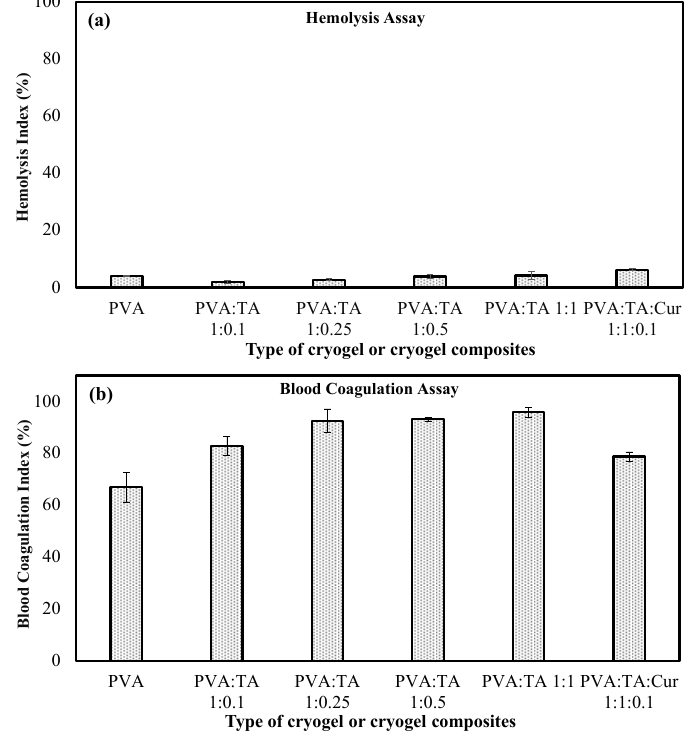
Figure 4. TA and Cur release profiles from PVA:TA:Cur 1:1:0.1 cryogel composites, ( a ) TA release profiles in EtOH and EtOH:Wat by UV-Vis spectroscopy, and ( b ) Cur release profiles in EtOH and EtOH:Wat by fluorescence spectroscopy. Digital camera images of these cryogels under ( c ) 366 nm UV light, and ( d ) daylight.